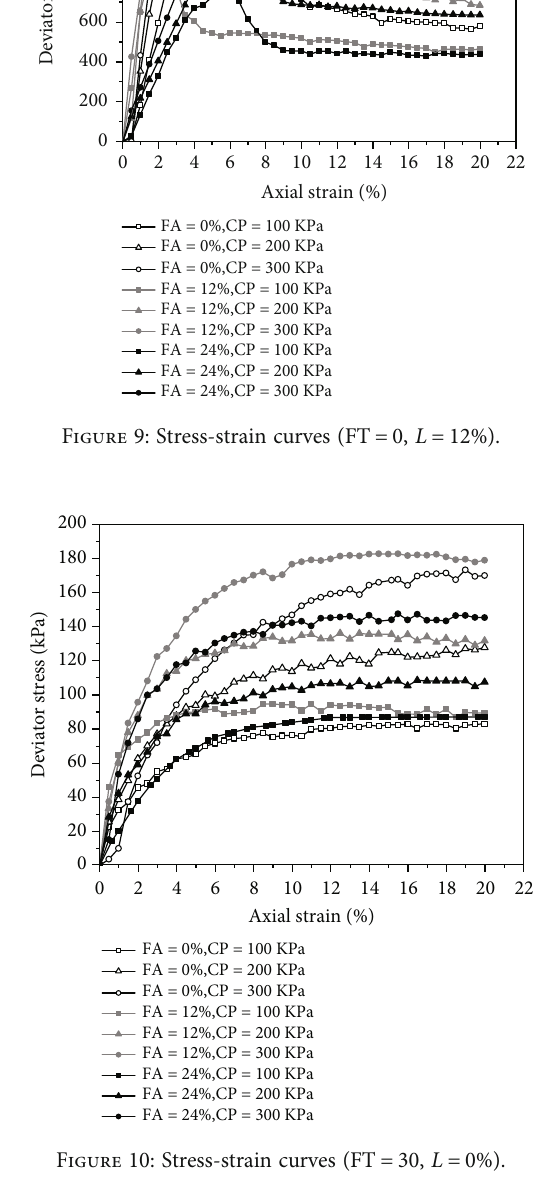
Figure 8: Stress-strain curves ( FT = 0 , L = 6 % ).